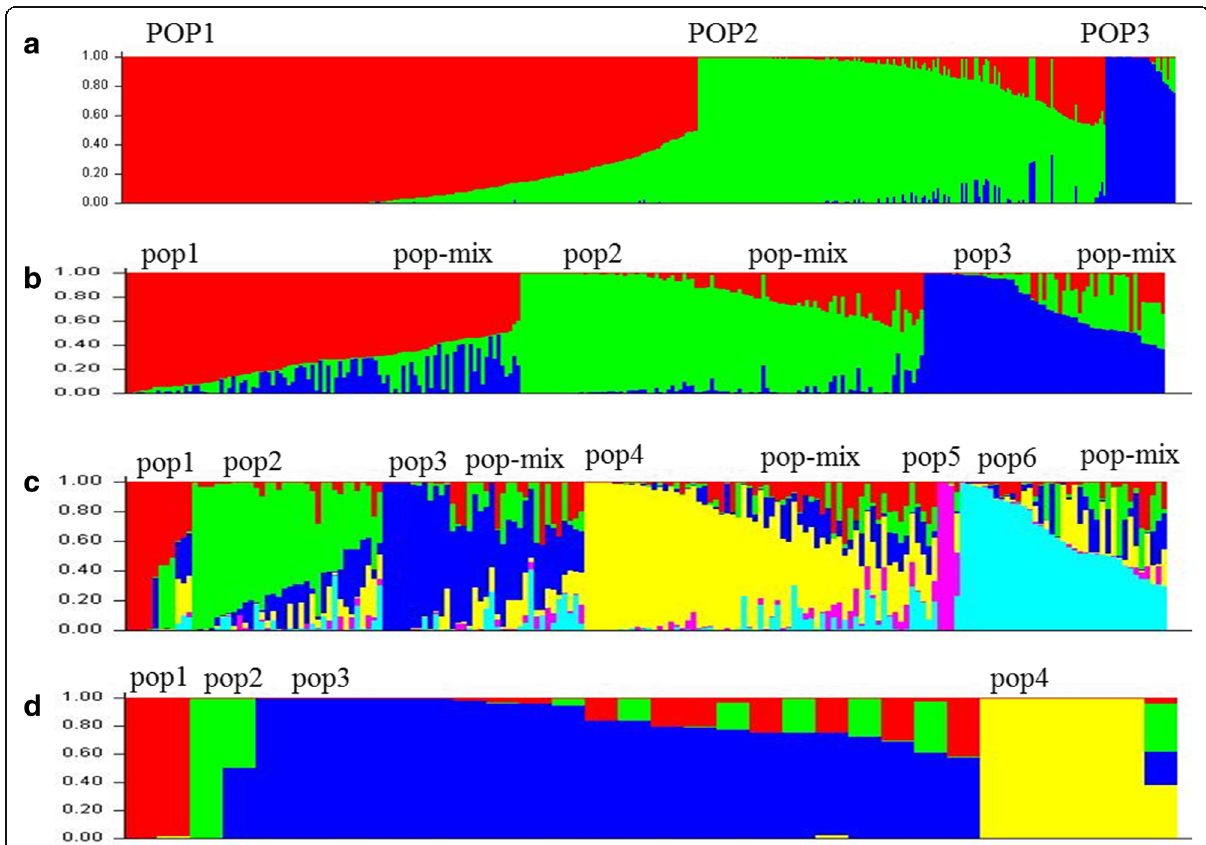
Fig. 5 Population Structure of 3 groups. a Four hundred eighty-one rice germplasms were divided into 3 groups: POP1, POP2 and POP3; b the subgroups of POP1; c the subgroups of POP2; d the subgroups of